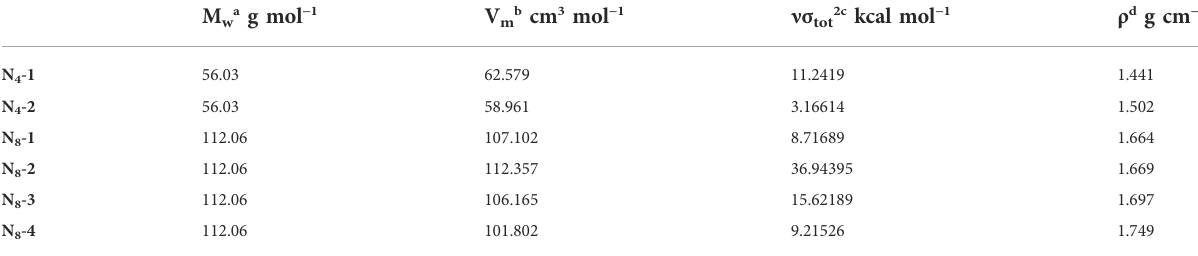
TABLE 1 B3LYP-6-311++G(d,p) computed properties and calculated densities for N 4 and N 8 allotropes.